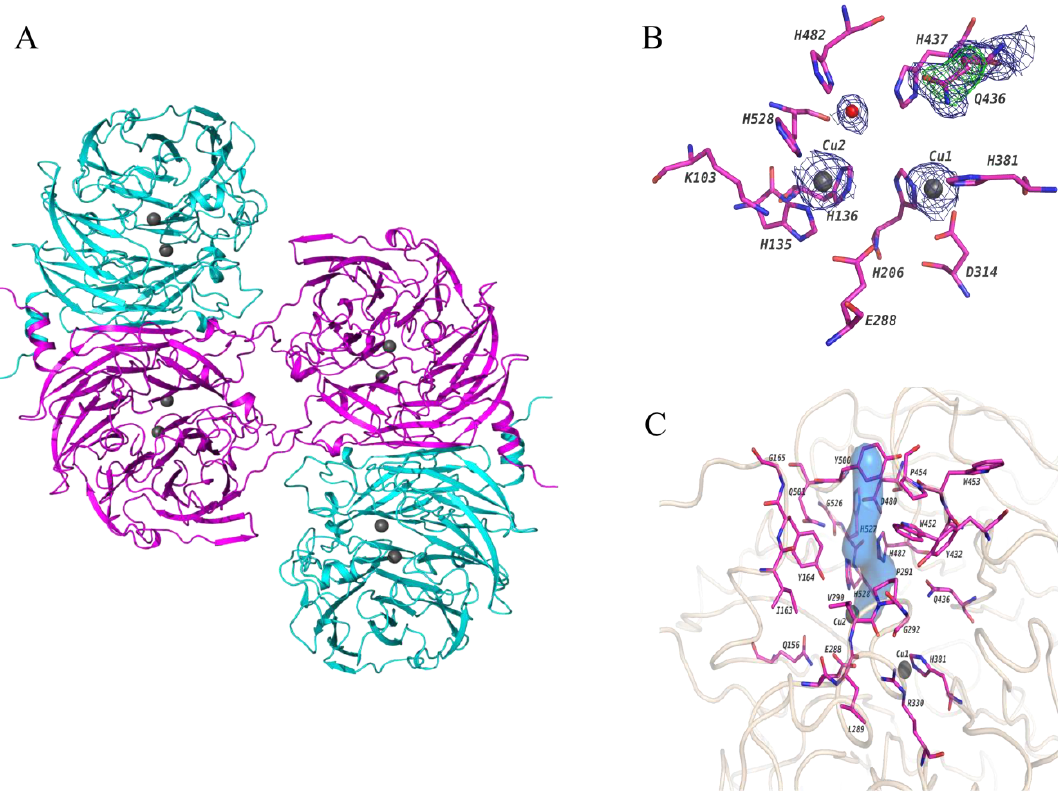
Figure 2. ( A ) The structure of TcDH F436Q tetramer from an asymmetric unit. The internal and external subunits are shown in magenta and cyan, respectively. Copper ions are presented in gray spheres. ( B ) The structure of TcDH F436Q active center. The amino acid residues are colored by elements. Copper ions and solvent molecules are presented in gray and red spheres, respectively. The (2Fo-Fc) electron density map at 1 σ level and omit (Fo-Fc) electron density map for Q436 at 3 σ level are shown as blue and green mesh, respectively. ( C ) The substrate channel of TcDH F436Q . The residues forming the channel are presented on panel ( B ). Copper ions are presented in gray spheres. The channel is depicted as blue surface.